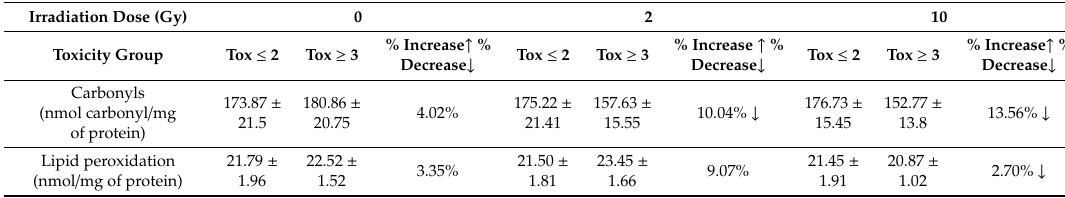
Table 5. Protein carbonylation and lipid peroxidation in erythrocyte lysates in both groups of patients. Groups Tox ≤ 2 and Tox ≥ 3 correspond to patients presenting grade 2 or less and grade 3 or more of late skin reactions after RT according to RTOG / EORTC, respectively. Percentages of increase and decrease were calculated to compare Tox ≥ 3 vs. Tox ≤ 2 group.